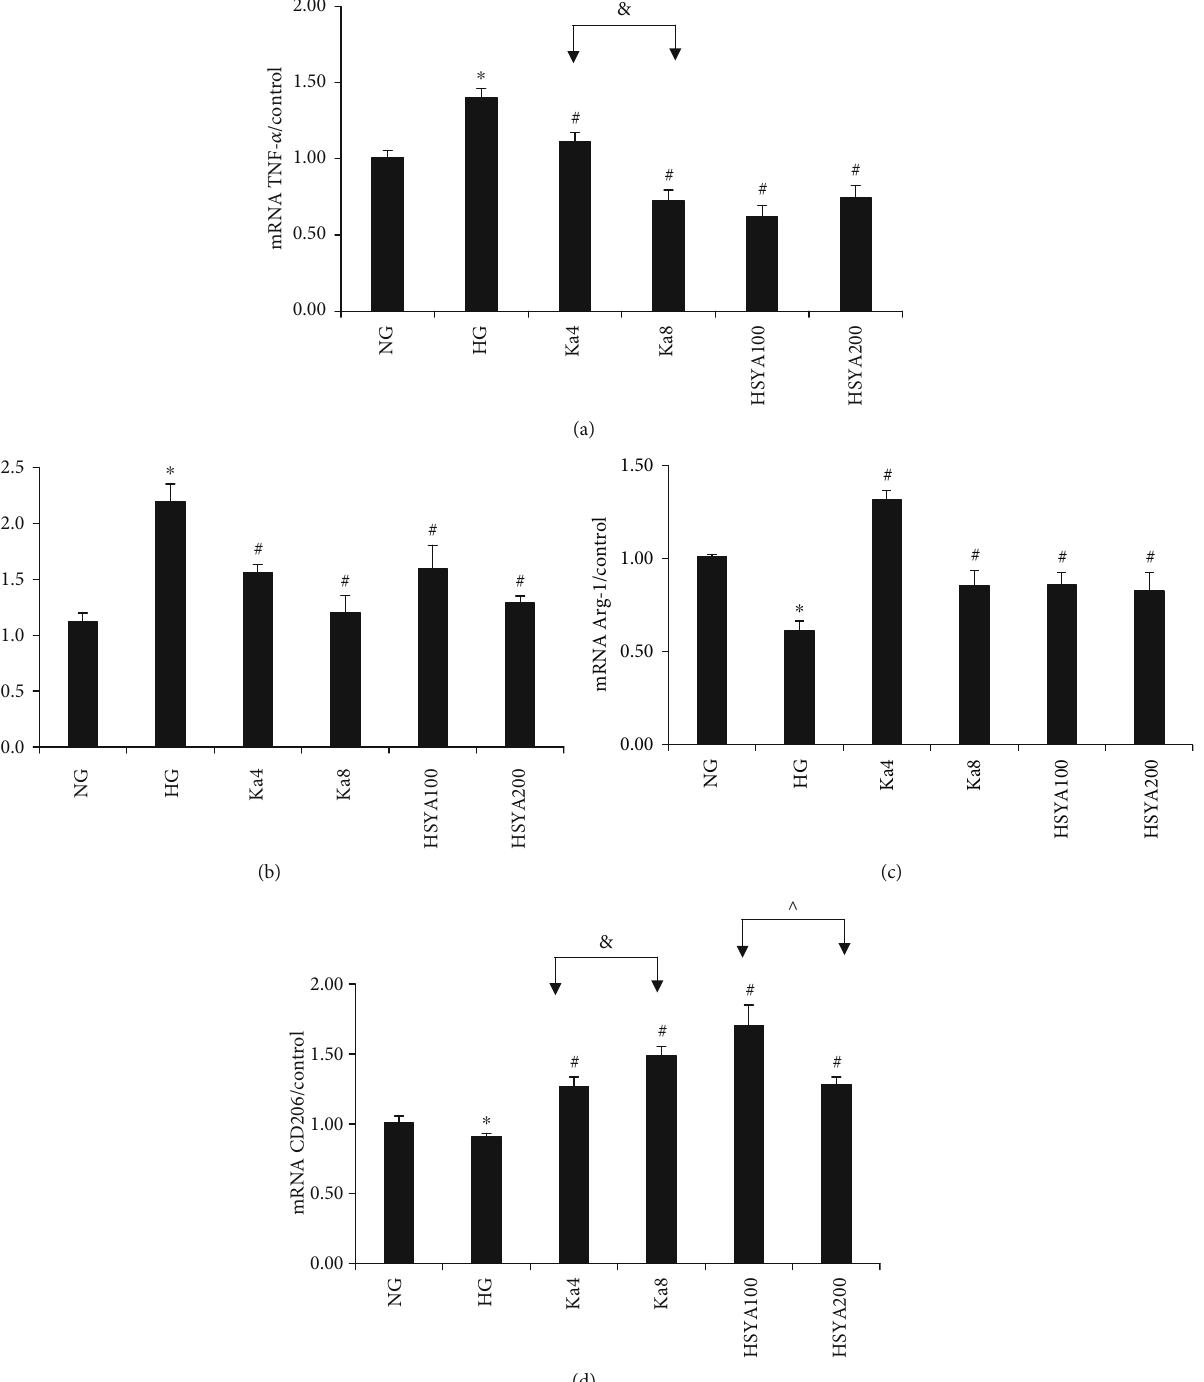
Figure 4: The e ff ects of Ka and HSYA on iNOS, TNF- α , Arg-1, and CD206 expressions in HG-induced macrophages as measured by real- time quantitative PCR. (a) TNF- α results. (b) iNOS results. (c) Arg-1 results. (d) CD206 results. All results were expressed as a ration with respect to control and represented as the mean ± SD in triplicates. ∗ p < 0 : 05 versus NG. # p < 0 : 05 versus HG. & p < 0 : 05 , Ka4 versus Ka8. ^ p < 0 : 05 , HSYA100 versus HSYA200. Abbreviations: NG: 11.1 mM glucose; HG: 33.3mM glucose; Ka4: kaempferol 4 μ M in HG; Ka8: kaempferol 8 μ M in HG; HSYA100: hydroxysa ffl or yellow A 100 μ M in HG; HSYA200: hydroxysa ffl or yellow A 200 μ M in HG; TNF- α : tumor necrosis factor- α ; iNOS: inducible nitric oxide synthase; CD206: mannose receptor; Arg-1: